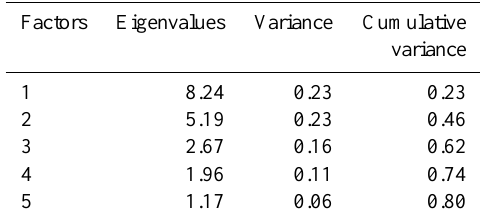
Table 6. Eigenvalue, variance and cumulative variance explained by factor analysis in topsoil samples ( n =